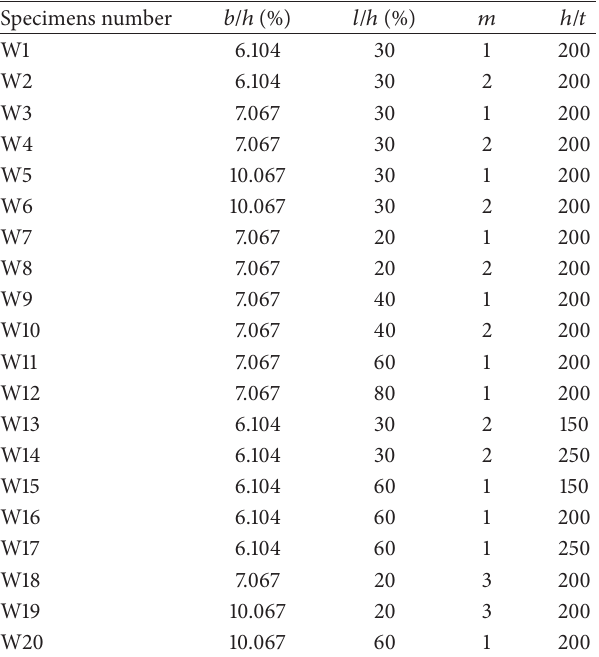
Table 1: Geometric parameters for the steel slit